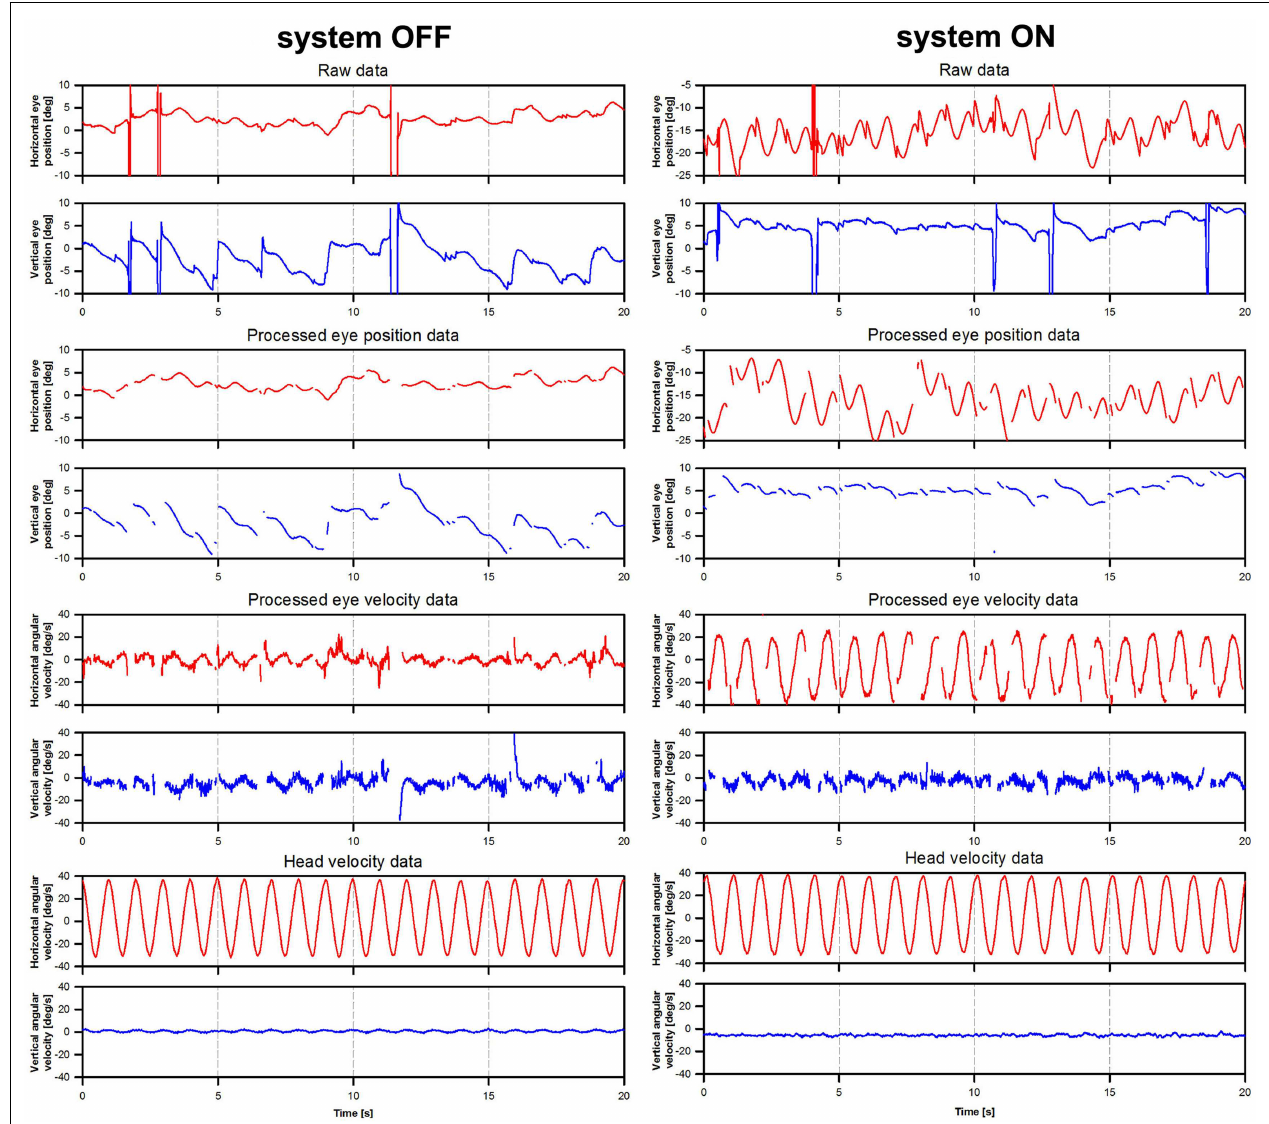
right show data gathered during the system ON experiments.Three steps are illustrated: raw eye position (e.g., before any processing was performed), processed eye position data (e.g., eye position data after blinks and quick eye movements > 1000°/s 2 were removed), and processed eye velocity data (e.g., obtained from the differentiation of the processed eye position